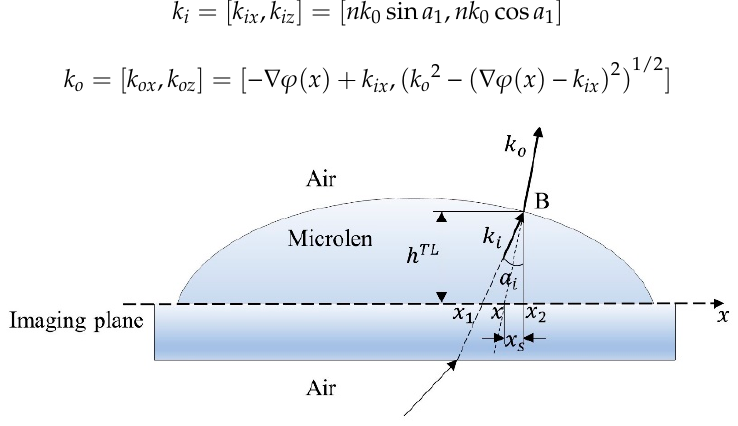
Figure 5. Illustration of tilted local ray approximation algorithm (TLRA) algorithm for DHM system in transmission.